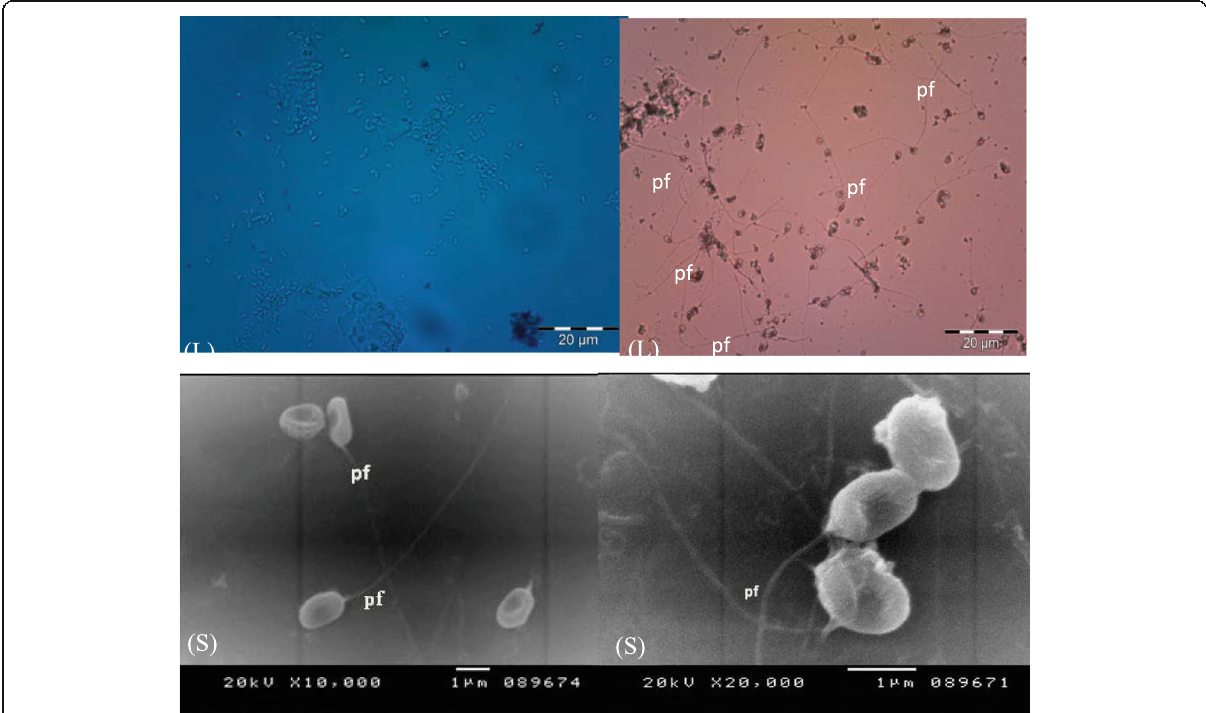
Fig. 3 Light (L) and scanning electron (S) microscope views of Nosema spores isolated from Rhyzopertha domini ca. Note the extruded polar filament